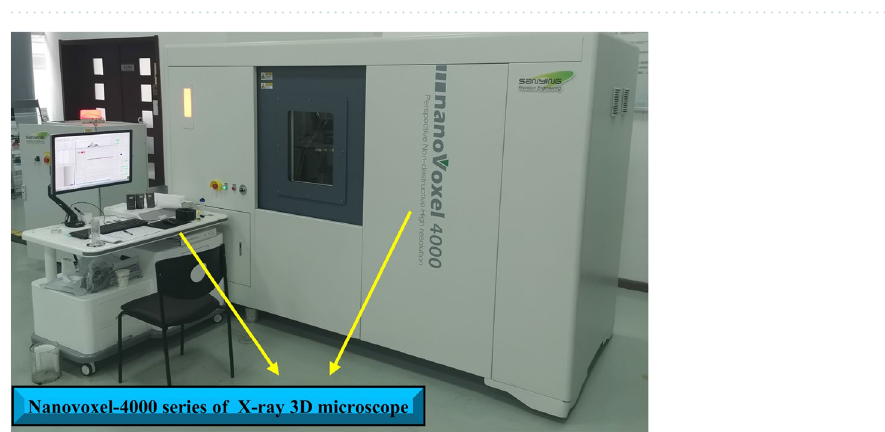
Figure 3. SEM morphology of marble samples exposed to 1000 °C after standing for 120 h at room temperature: ( a ) × 300; ( b ) × 500; ( c ) × 2000; ( d ) × 5000; ( e ) × 30,000; ( f ) × 50,000.